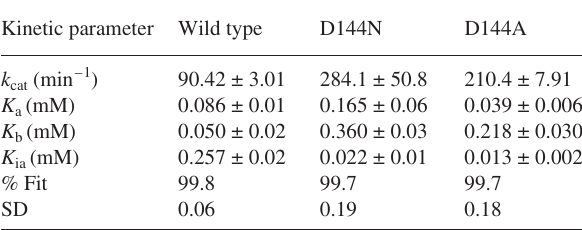
Table 2. Kinetic parameters for the wild-type, D144N and D144A sn -glycerol-1-phosphate dehydrogenases (Gro1 P DH) in dihydroxy- acetone phosphate (DHAP) reduction with NADPH as the coenzyme.